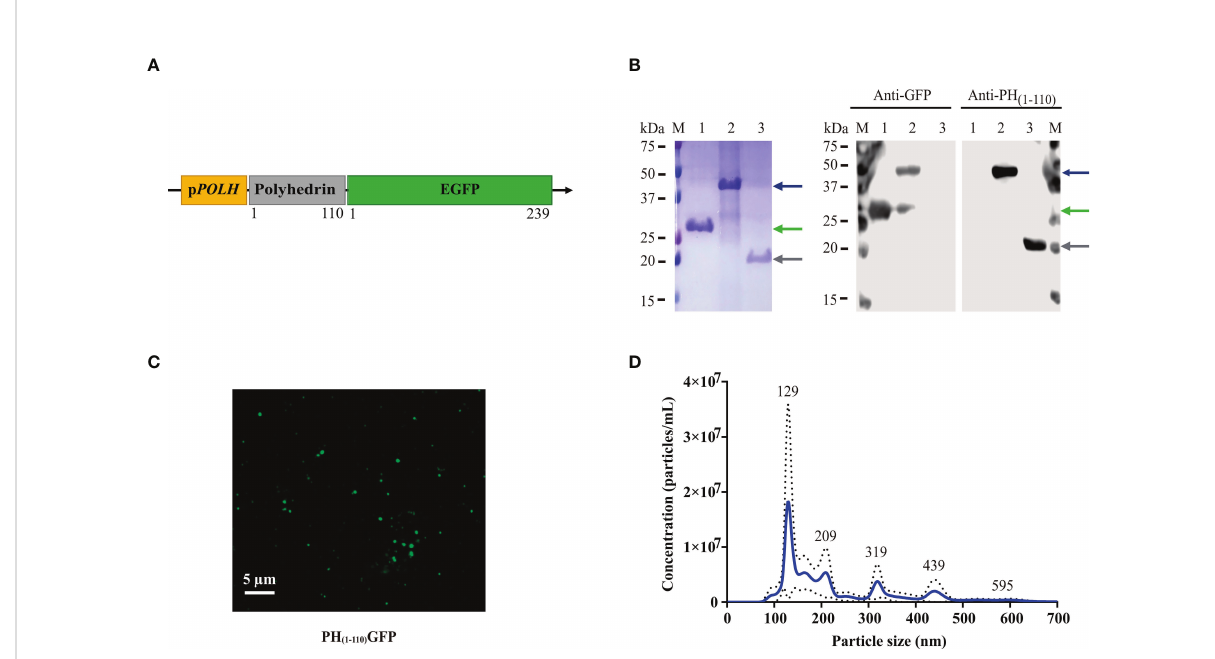
FIGURE 1 Generation and characterization of PH (1-110) GFP NPs. (A) Schematic diagram of the genetic construct for the expression of PH (1-110) GFP NPs in the baculovirus insect cell expression system. The coding sequences for the N-terminal 110 aa of polyhedrin and GFP were inserted under the pPOLH promoter. (B) SDS-PAGE and Western Blot analysis of PH (1-110) GFP expression. Lane M: molecular weight markers; Lane 1: GFP; Lane 2: PH (1-110) GFP; Lane 3: PH (1-110) . Blue arrow: PH (1-110) GFP (~42 kDa); Green arrow: GFP (~28 kDa); Gray arrow: PH (1-110) (~19 kDa). (C) Confocal microscopy of puri fi ed PH (1-110) GFP NPs. (D) Nanoparticle Tracking Analysis of puri fi ed PH (1-110) GFP NPs. Data represent mean ±